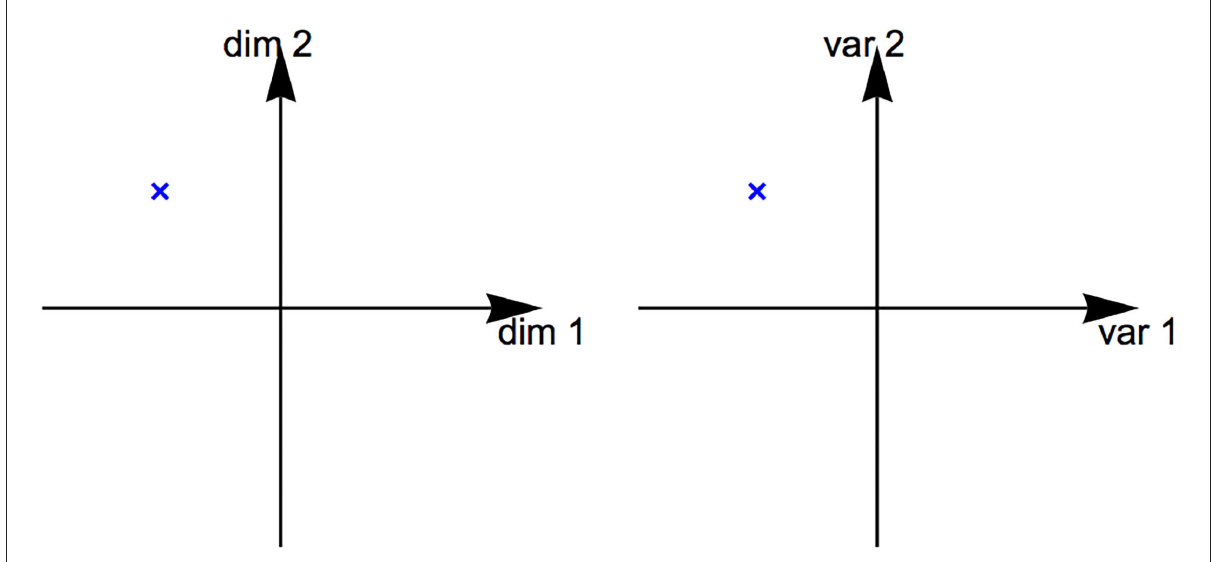
FIGURE1 Multidimensional space (left) and multivariate space (right). For auditory and visual data representation, dimensions and variables can sometimes be treated the same.